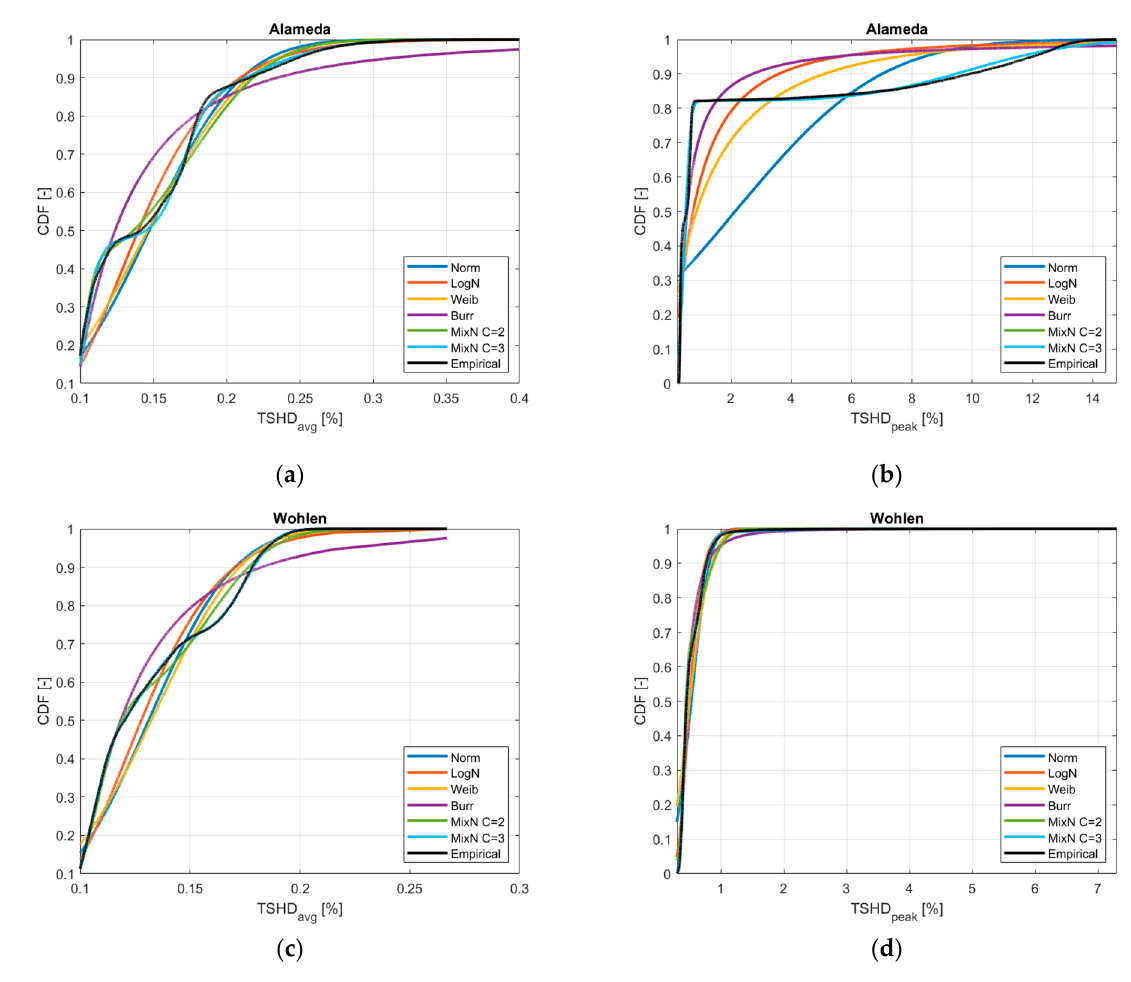
Figure 1. Estimated and empirical CDFs of the: ( a ) TSHD avg at Alameda (CA); ( b ) TSHD peak at Alameda (CA); ( c ) TSHD avg at Wohlen (Swizterland); ( d ) TSHD peak at Wohlen (Swizterland). The quantitative assessment of the GOF is reported in Table 1 through the ADC. Bold values indicate the best fit. The MixN distribution with (cid:1829) = 3 components is always the best pick as it returns the greatest ADC in all the considered locations and scenarios. Table 1. Adjusted determination coefficient of the TSHD distributions. Bold values indicate the best fit.